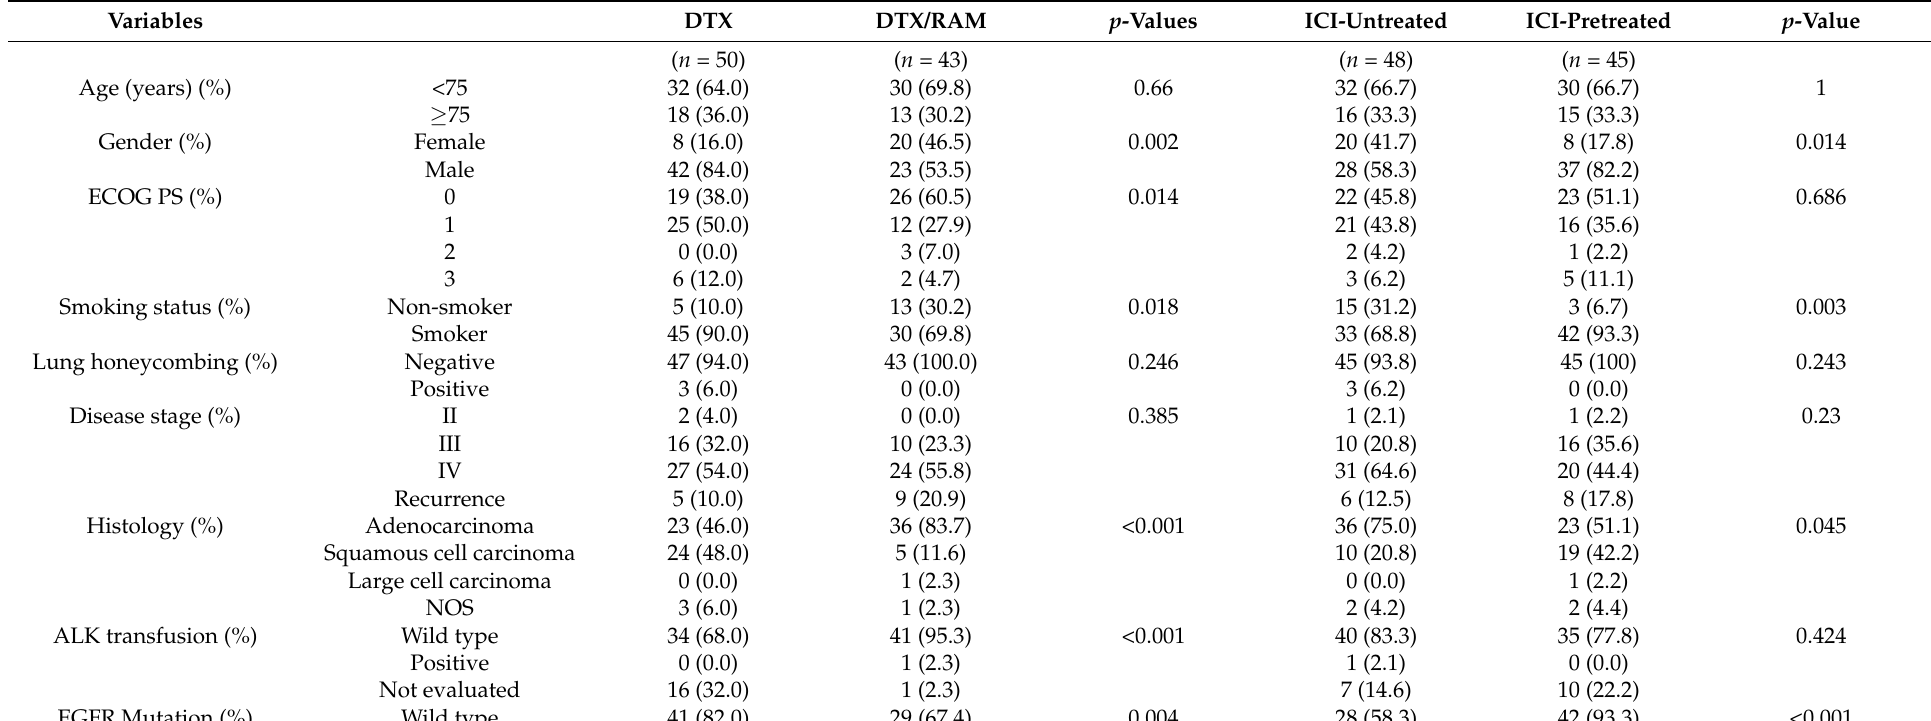
Table 1. Clinical characteristics of the study